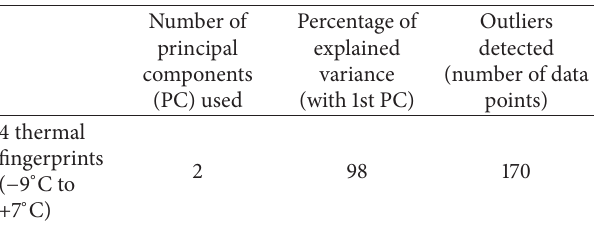
Table 2: PCA statistical indicators for the UK